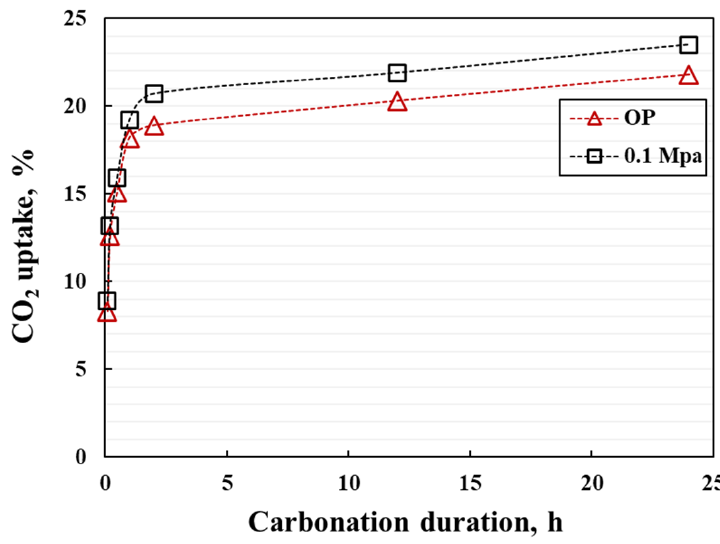
Figure 11. CO 2 uptake rate of the coating during the carbonation.